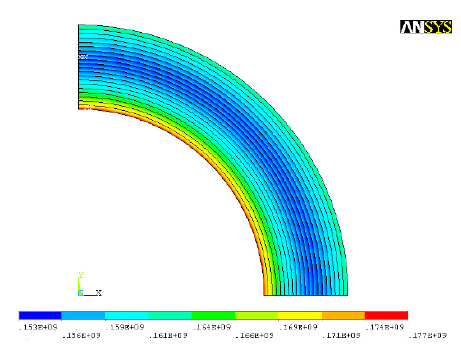
Figure 13. Circumferential stress obtained from ANSYS code in an FGM disk ( ξ = 1 . 5 , η = 3) .